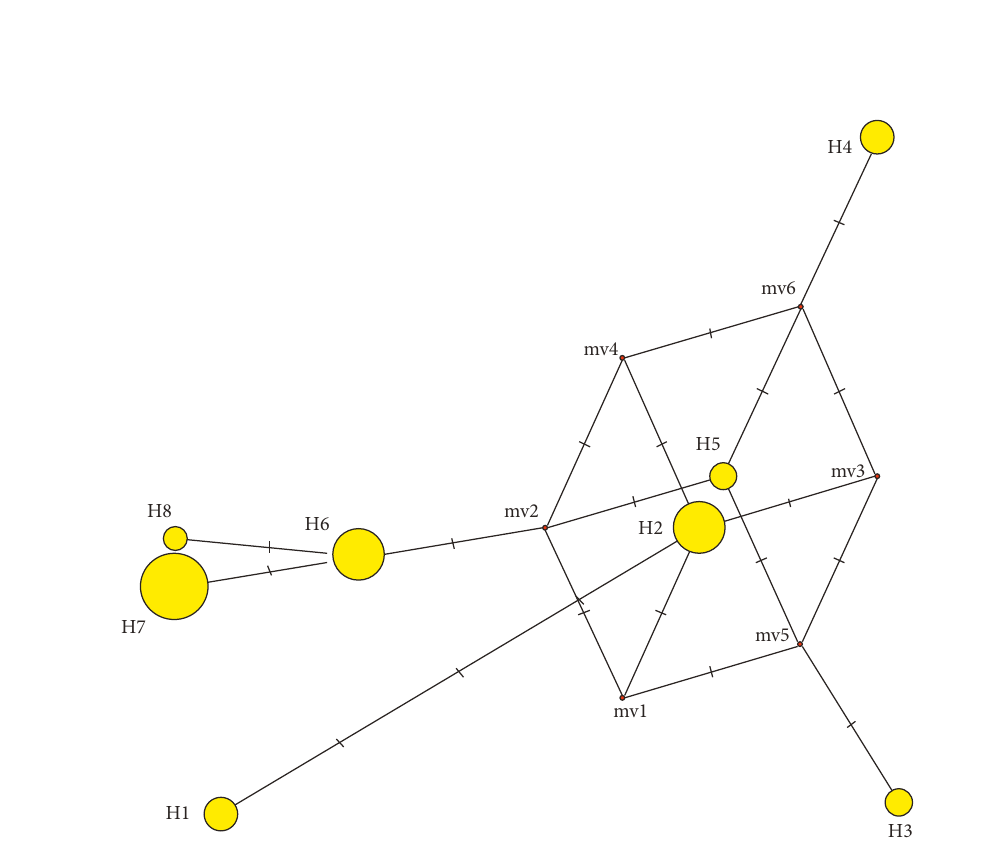
Figure 1: Median-joining network showing the genetic relationships among the eight detected chloroplast haplotypes. Circle sizes are proportional to the haplotype frequencies in the total studied